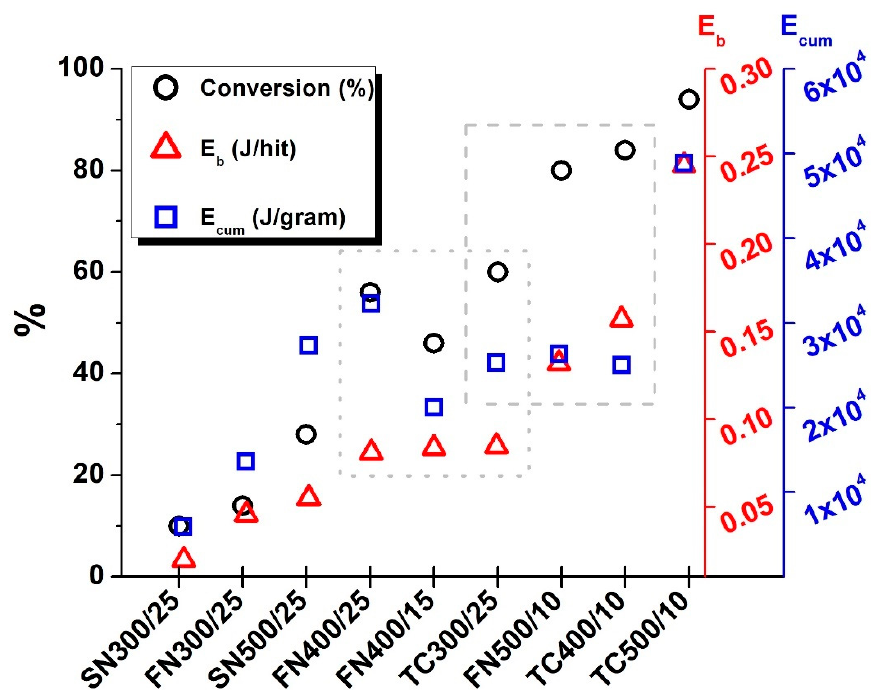
Figure 5. The conversion of the precursors ( ○ ), the ball-impact (E b , ∆ ) energy and the cumulative energy (E cum , □ ) in case of all grinding sets. The areas with the dotted and dashed lines show the samples compared in the text.